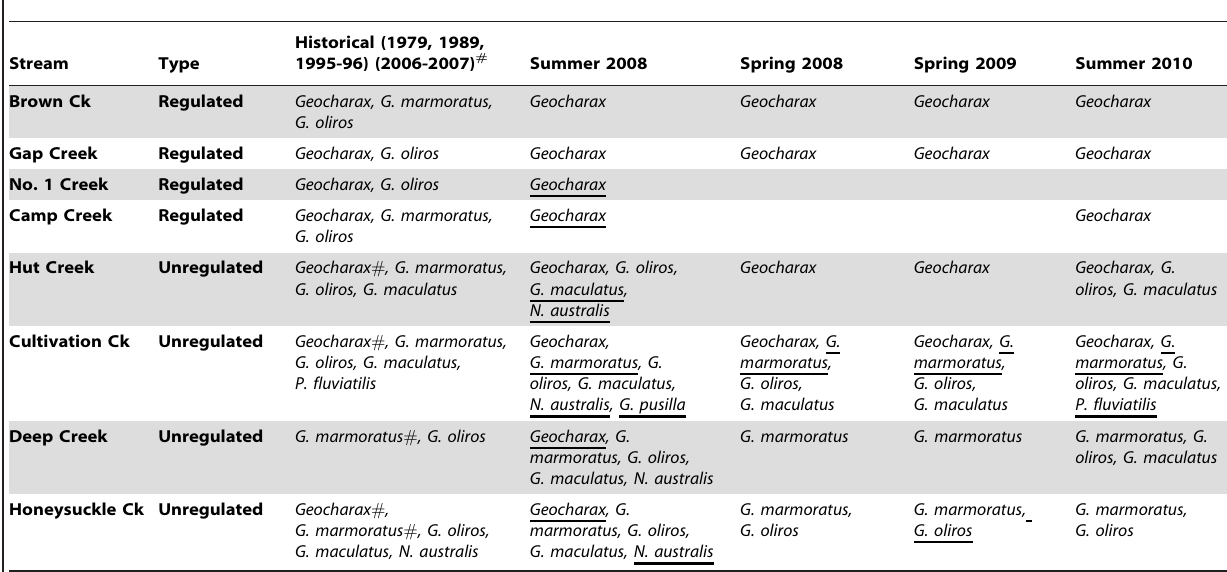
Table 1. Presence of fish and crayfish in the eight streams at each sampling time, compared with historical presences.